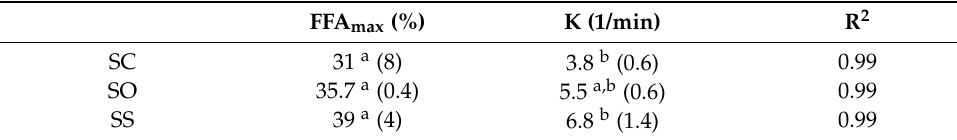
Table 4. Kinetic parameters of lipid digestion in steamed